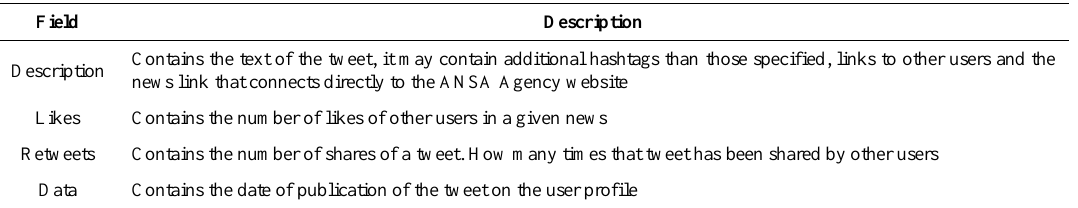
Table 1. Description of the extracted fields